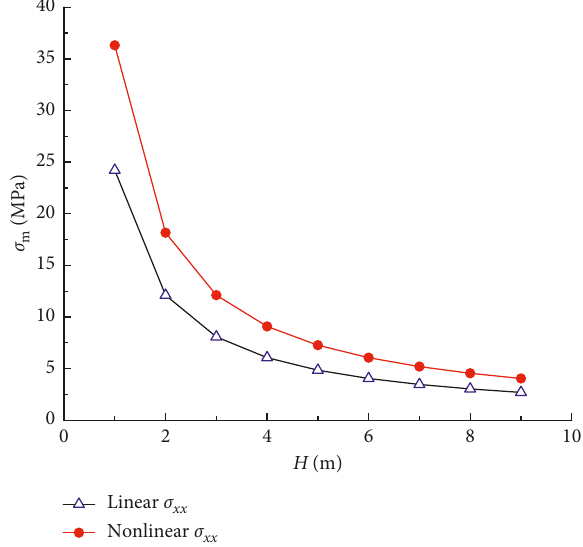
Figure 5: Stability curve of the symmetric pressure-arch structure of two key